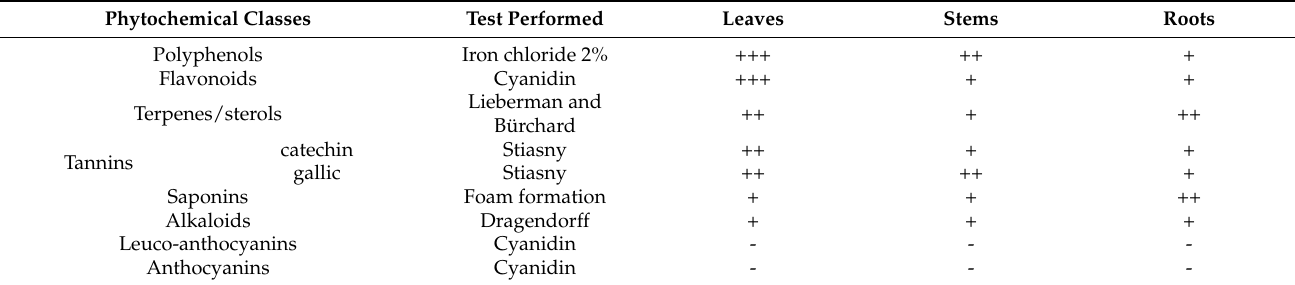
Table 1. Phytochemical screening of L. rhodesiensis